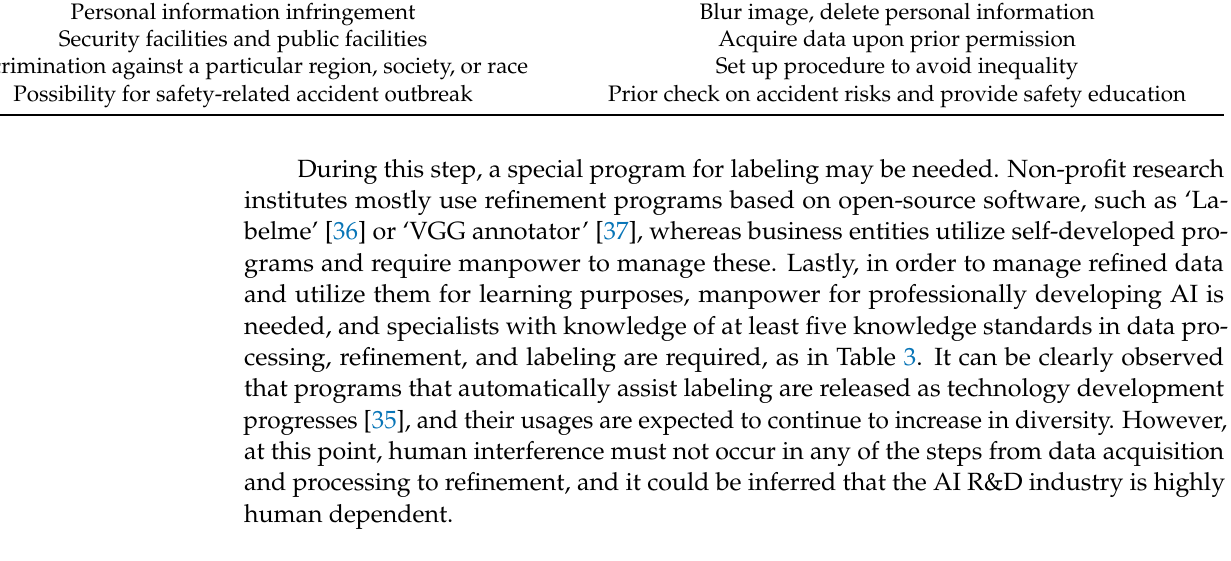
Table 3. Research process, human resources, and level of academic knowledge required for AI research and development prior to